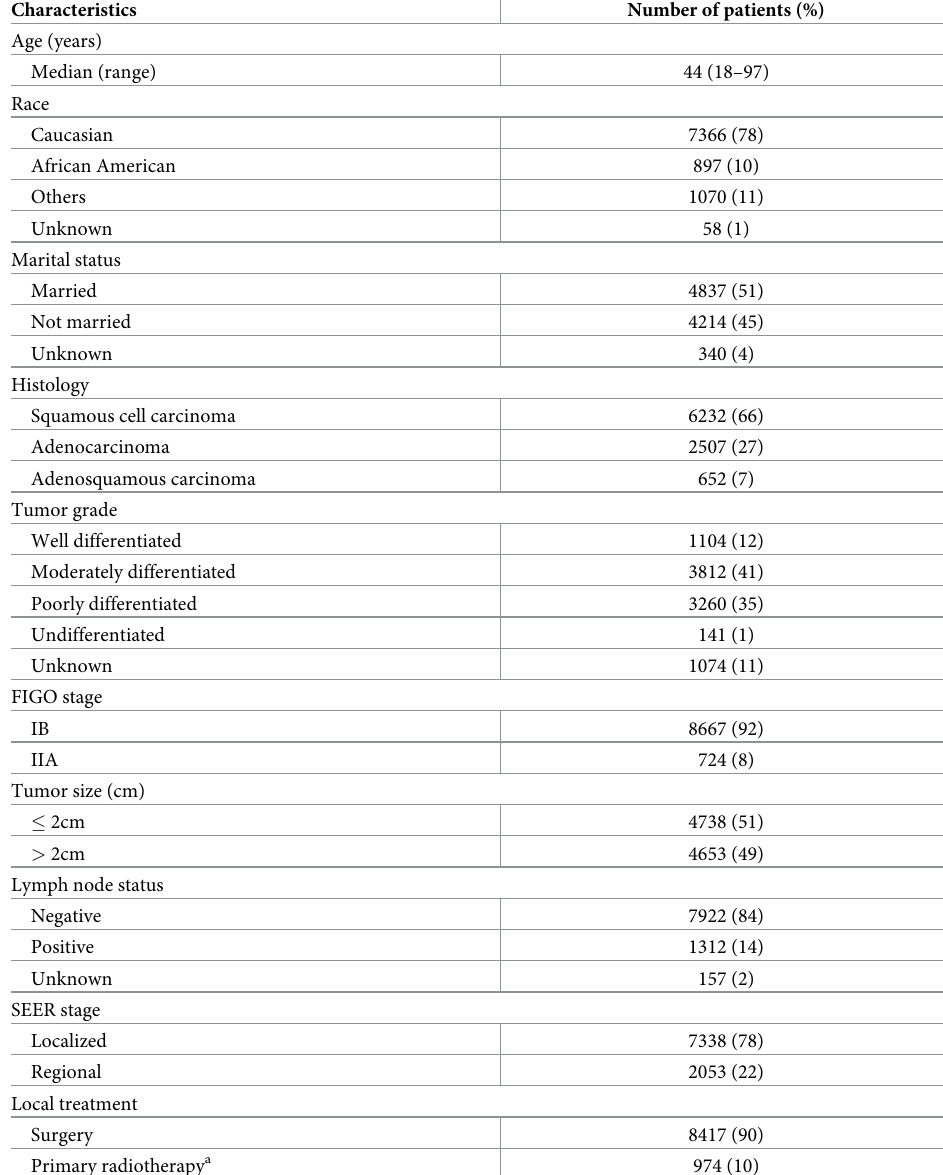
Table 1. Baseline characteristics of the initial study population (N = 9391).